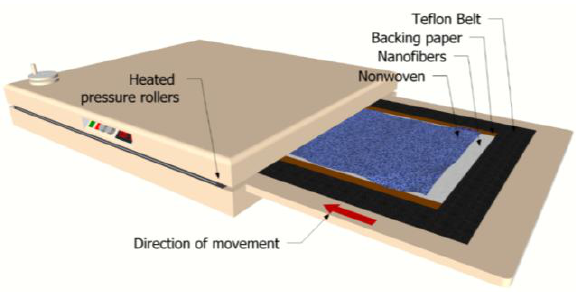
Figure 2. Lamination method and equipment [37].